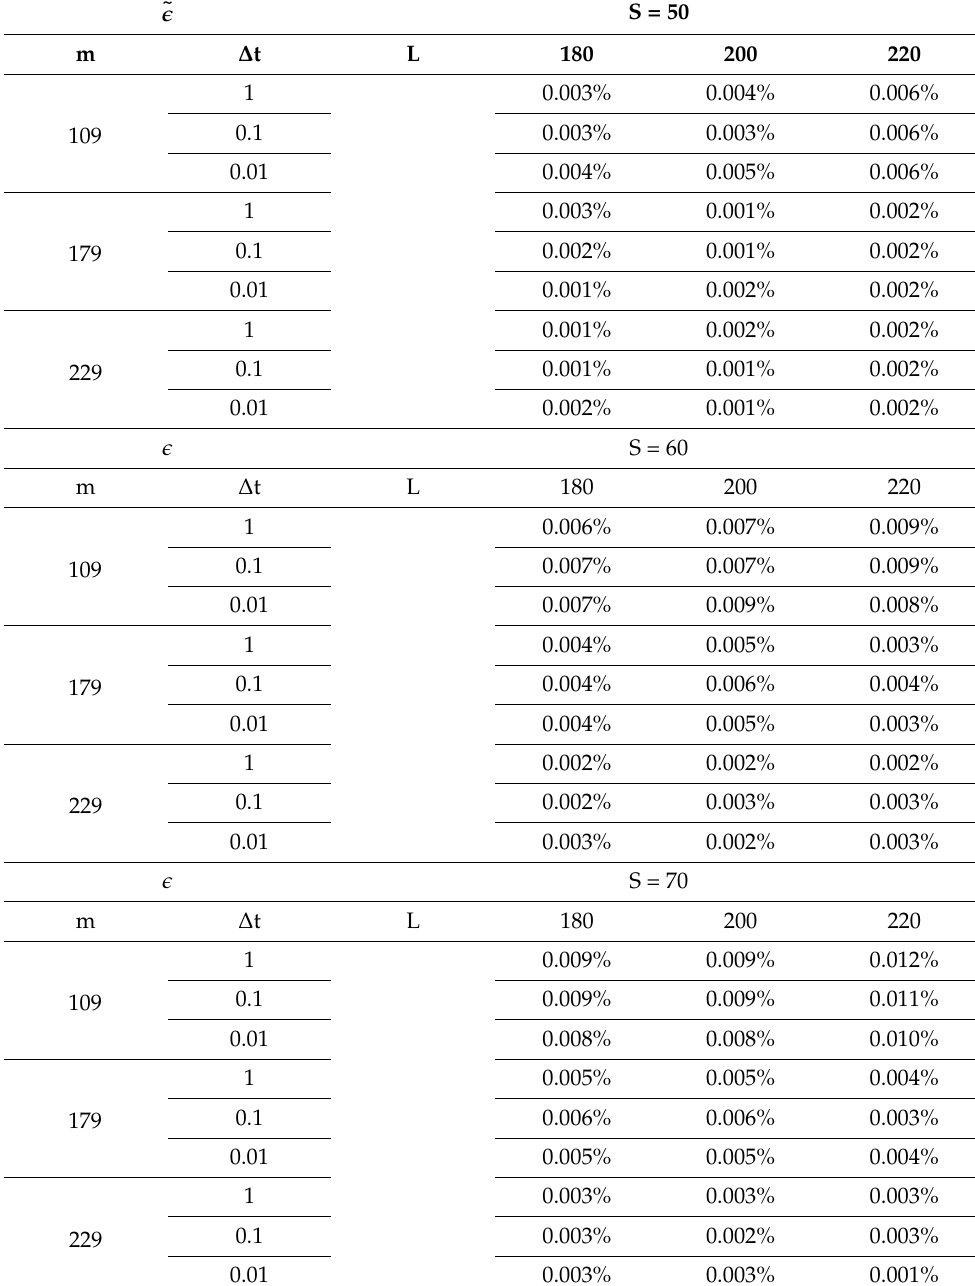
Table 4. The numerical error (cid:101) (cid:101) of areas by using different m, ∆ t, S and